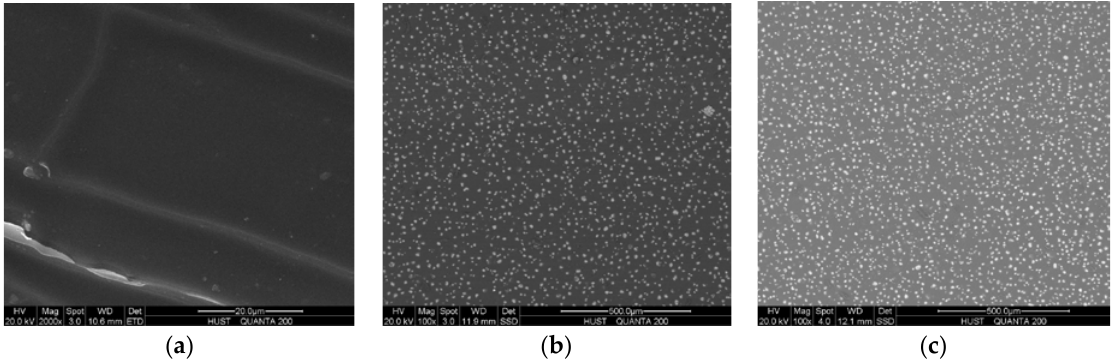
Figure 7. SEM skin layer of silicone composites with different mass fractions of phosphor: ( a ) 0%; ( b ) 20%; ( c ) 40%.